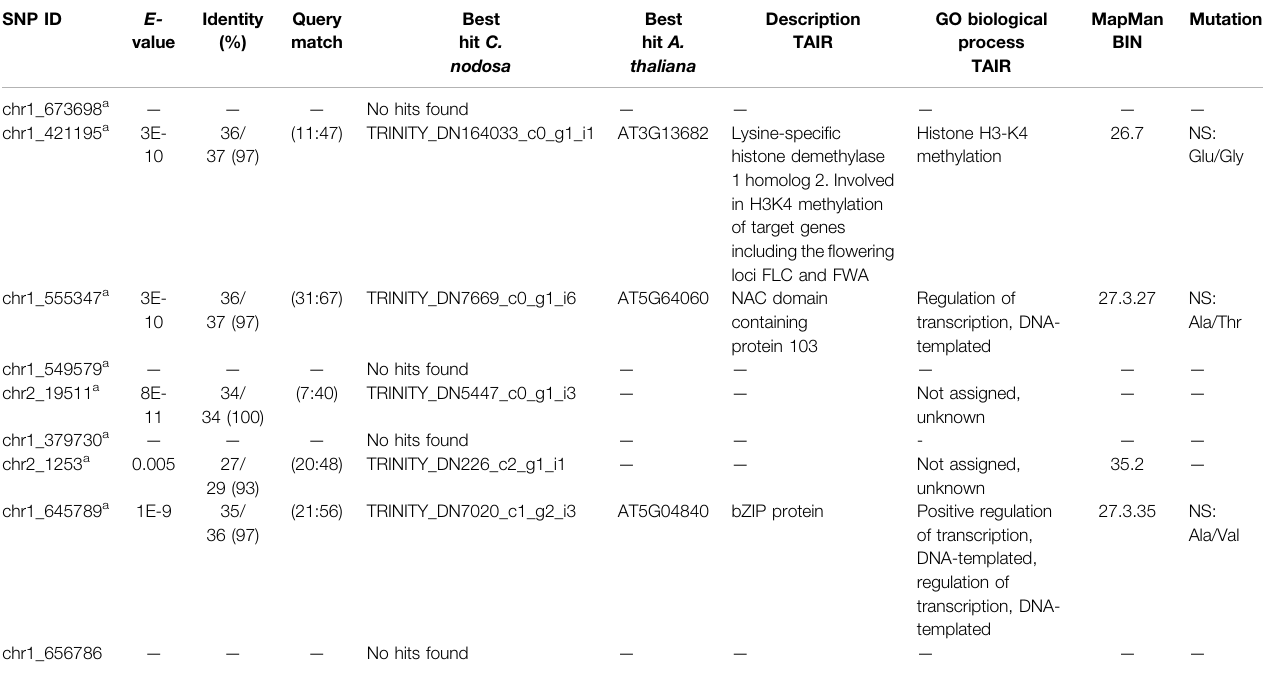
TABLE 2| Functional annotationsof the9 signi fi cantoutlierSNPs shared between BayeScan and pcadapt. SNPs ID; E -value;identity with %;bp ofthe query match; contig name(representingthebesthitoftheblastanalysisagainstavailabletranscriptomes b );name,descriptionandrelatedGOofthebesthitof Arabidopsisthaliana according toTAIR(https://www.arabidopsis.org/index.jsp); bin codesofMapMan classi fi cation; andmutationtypeoftheSNP(NS, nonsynonymous; SYN,synonymous),areoutlined. Full annotation of all outlier SNPs obtained with one or both methods can be retrieved from Supplementary Table S12